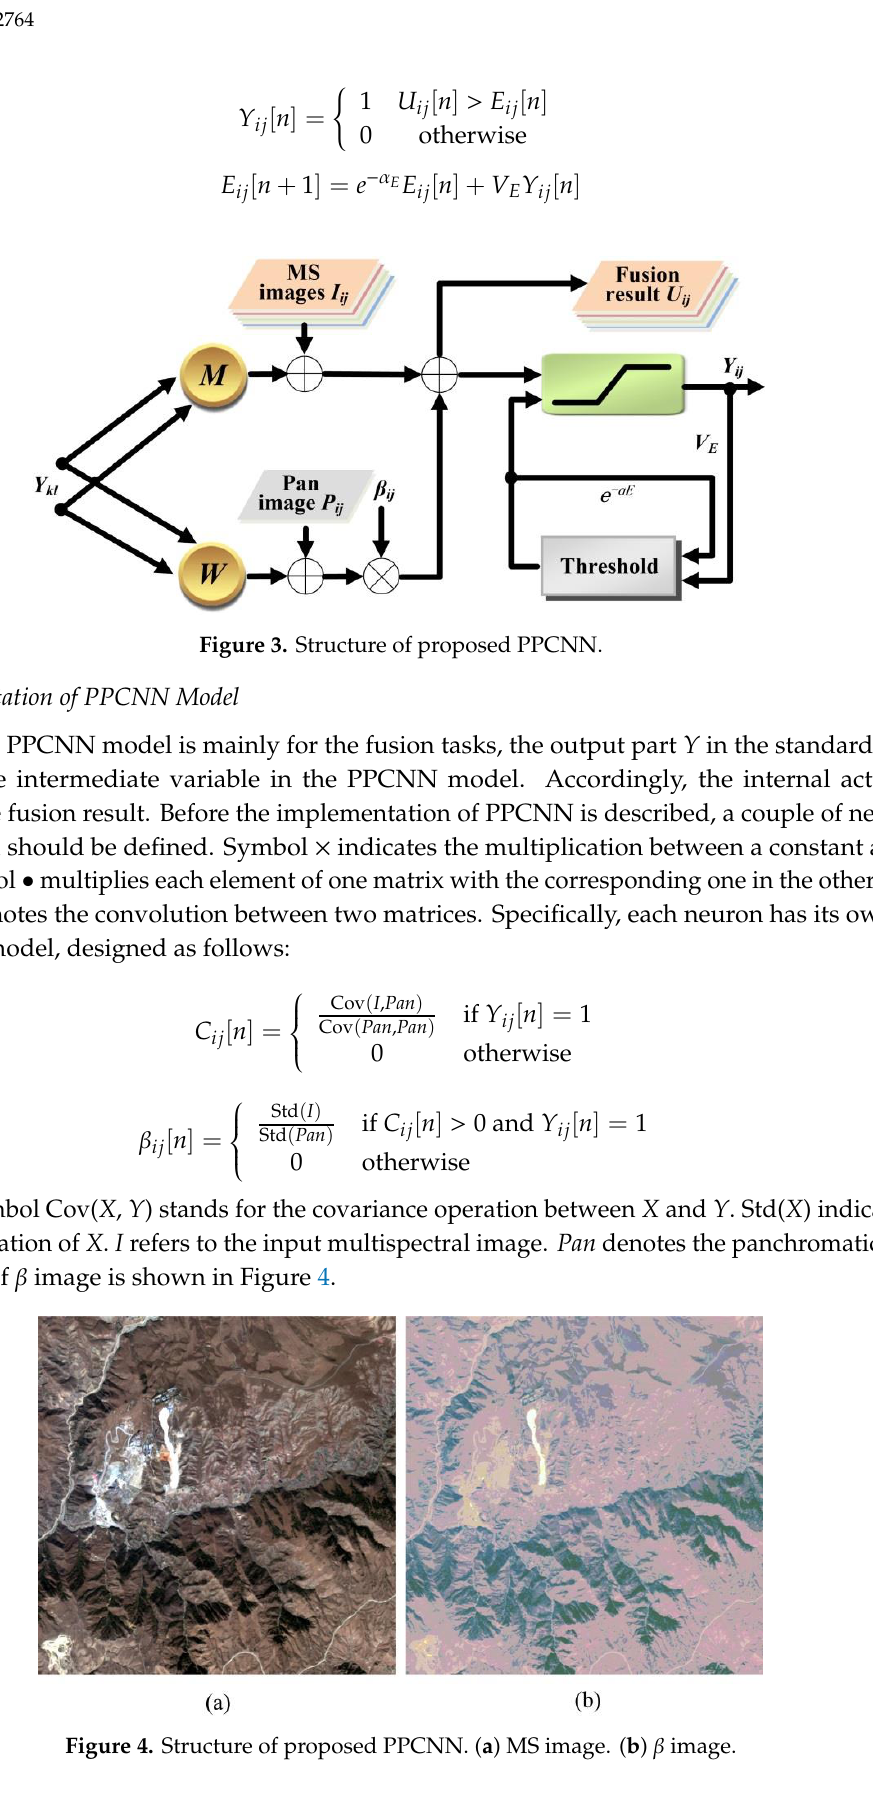
Figure 4. Structure of proposed PPCNN. ( a ) MS image. ( b ) β image.